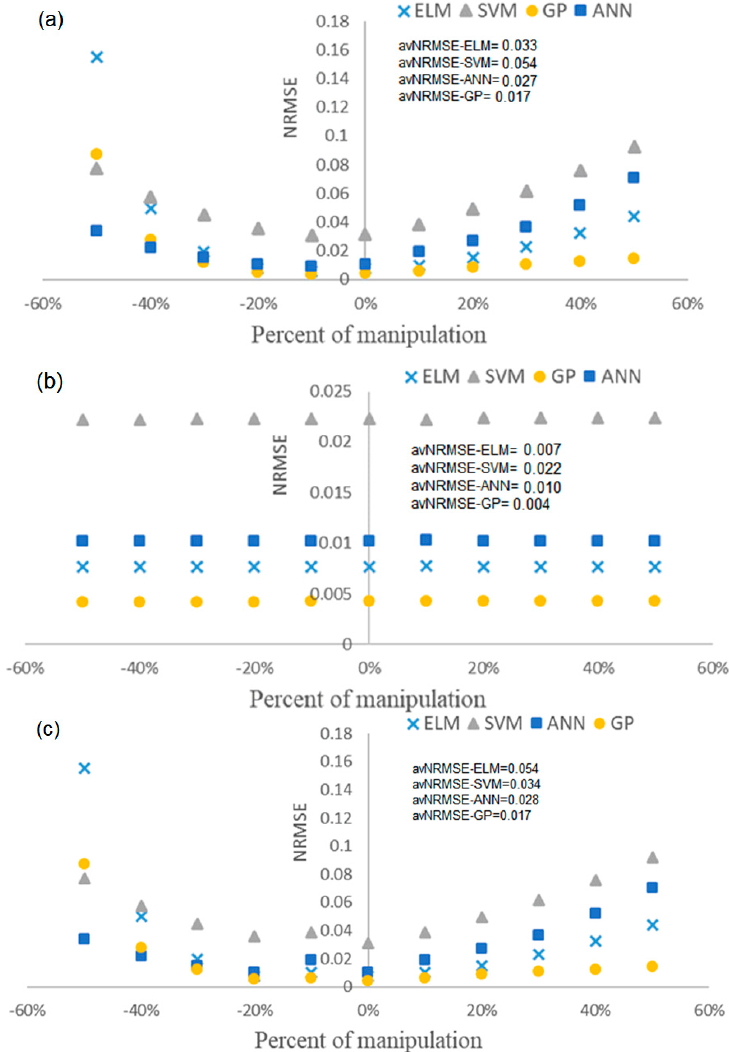
Figure 7. Results of the robustness evaluation for each model: ( a ) for k m,ac ; ( b ) for k hyd,ch ; ( c ) for k I,NH3 . NRMSE: normalized root-mean-squared error; avNRMSE: average normalized root-mean-squared error.